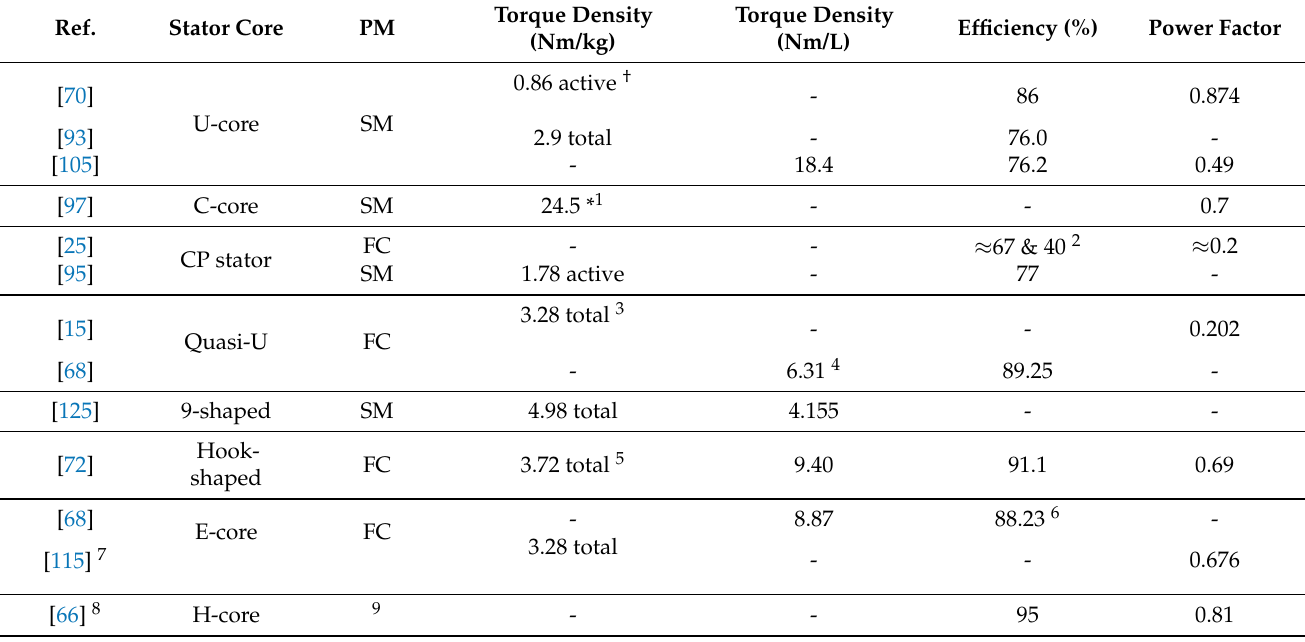
Table 2. Comparison of TFM